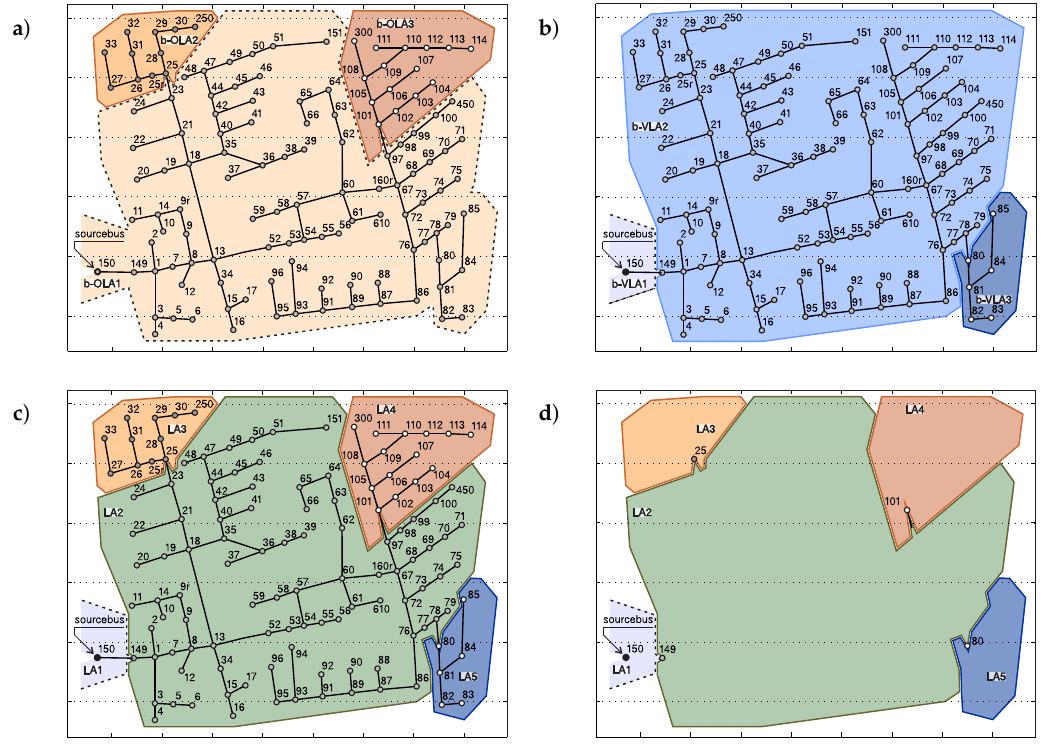
Figure 13. The 123-bus grid—( a ) b-OLAs; ( b ) b-VLAs; ( c ) b-LAs; and ( d ) compact representation by